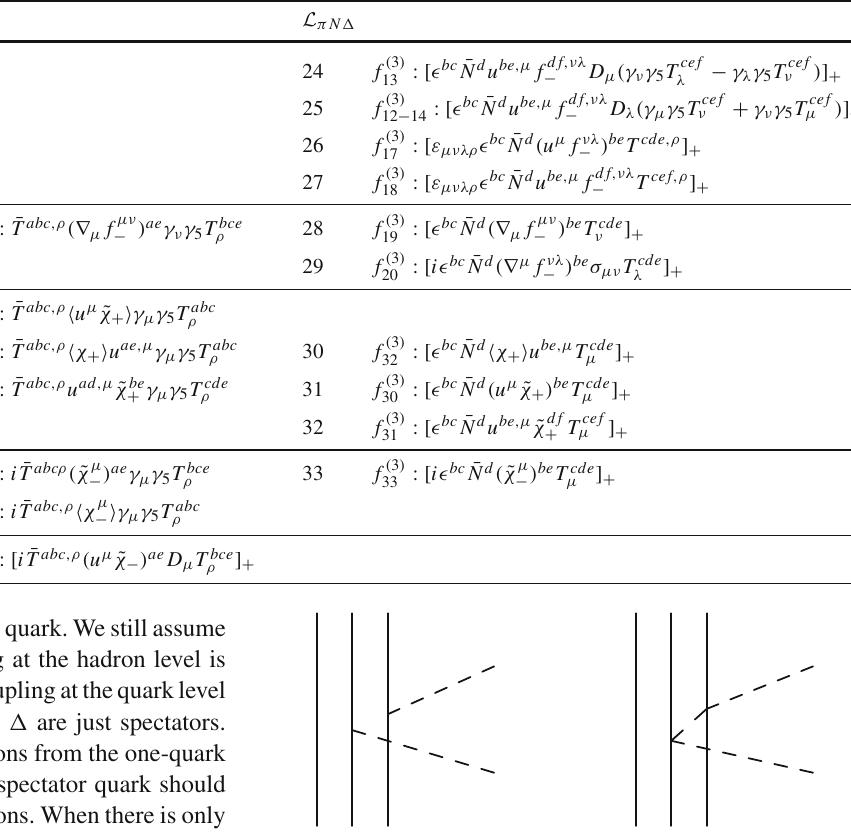
Fig. 1 Possible corrections to a (cid:2) - (cid:2) -boson or N - (cid:2) -boson coupling at the quark